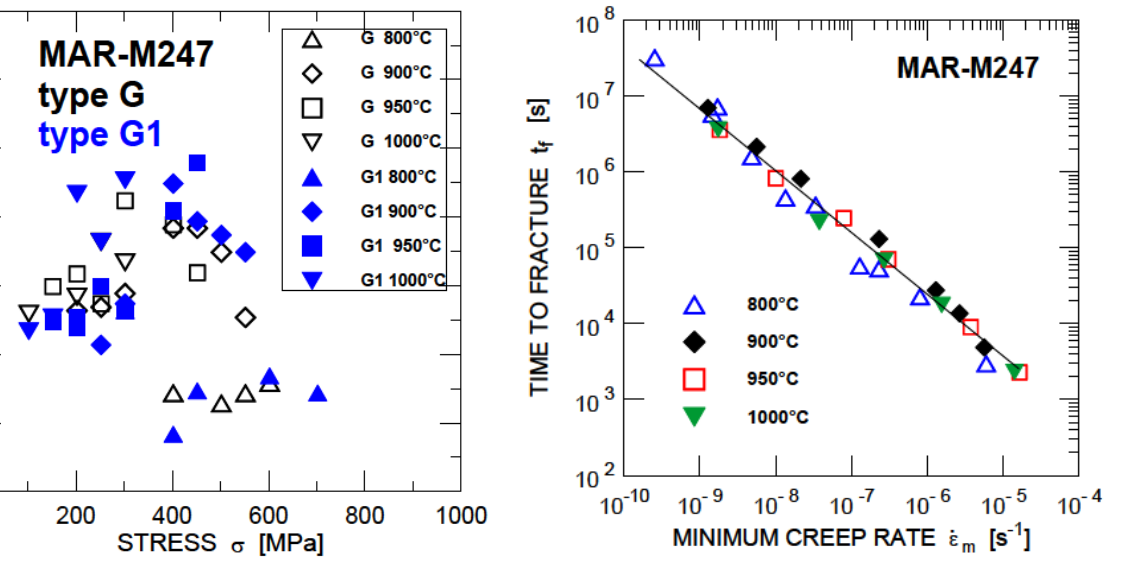
Figure 11: Stress dependence of fracture strain for superalloy MAR-M247 G and G1 alloys at different temperatures and applied stresses.